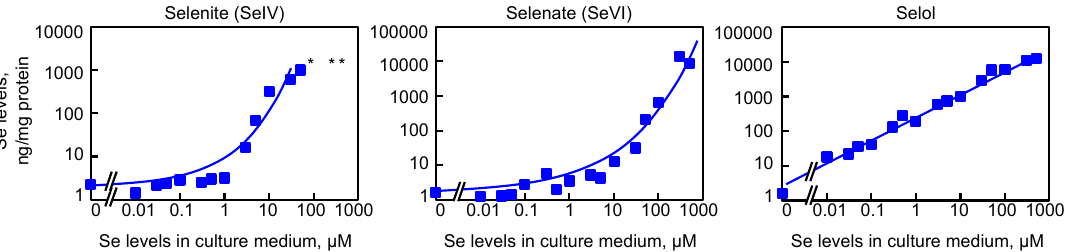
Figure 4. Measurement of selenium levels of HEK293 cells grown with increasing concentration of selenite, selenate or Selol in the culture media (from 10 nM up to 500 µM). Selenium levels are expressed relative to protein concentration. In several extracts, due to selenite toxicity, the protein recovery was too low to allow precise selenium detection and normalization, as indicated by an asterisk.